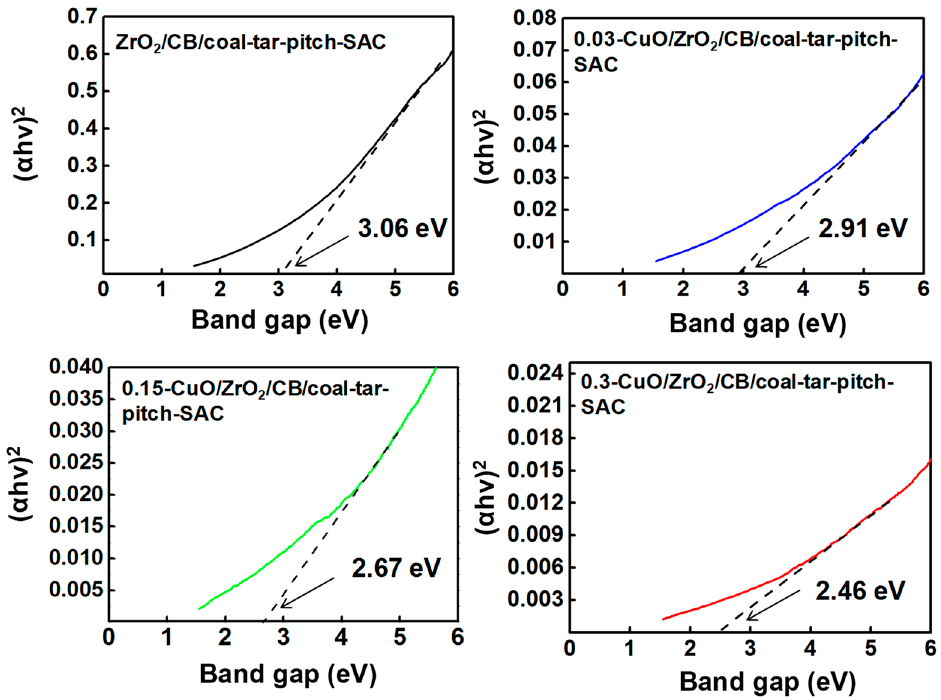
Figure 7. Plot of transformed Kubelka–Munk function versus the band gap (eV) of different samples. The sterilization effects of CuO/ZrO 2 /CB/coal-tar-pitch-SAC materials are